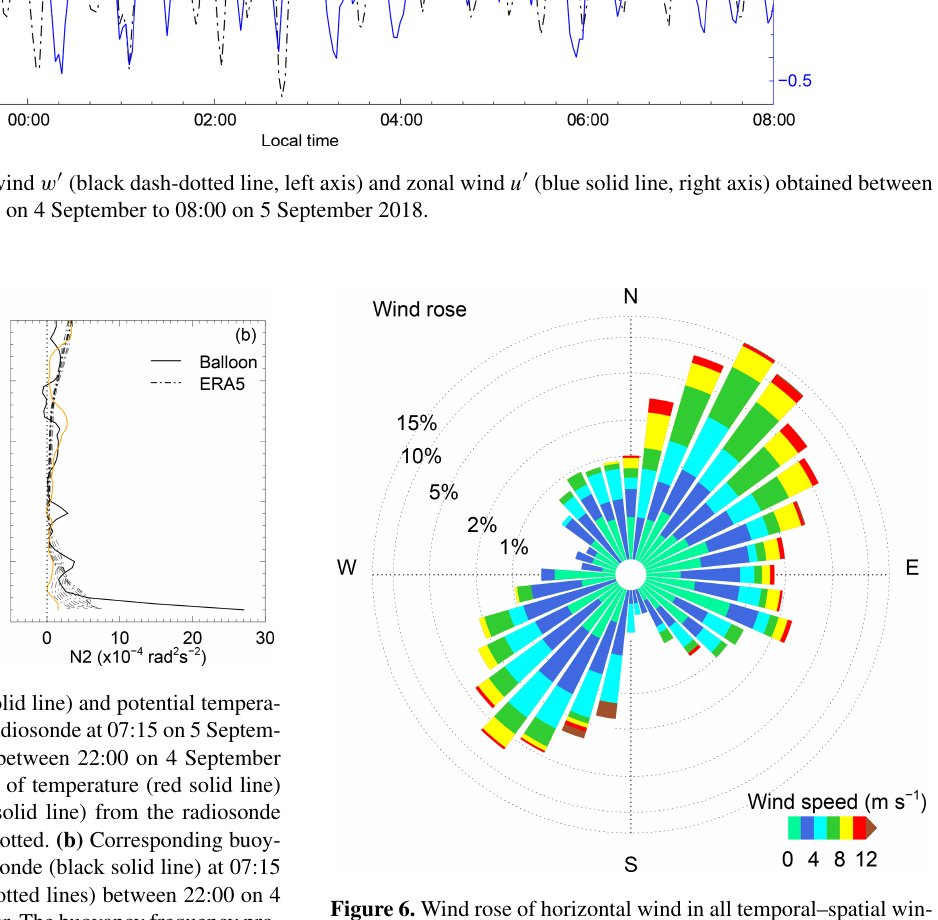
Figure 6. Wind rose of horizontal wind in all temporal–spatial win- dows during this experiment. It should be noted that the value of the radius is